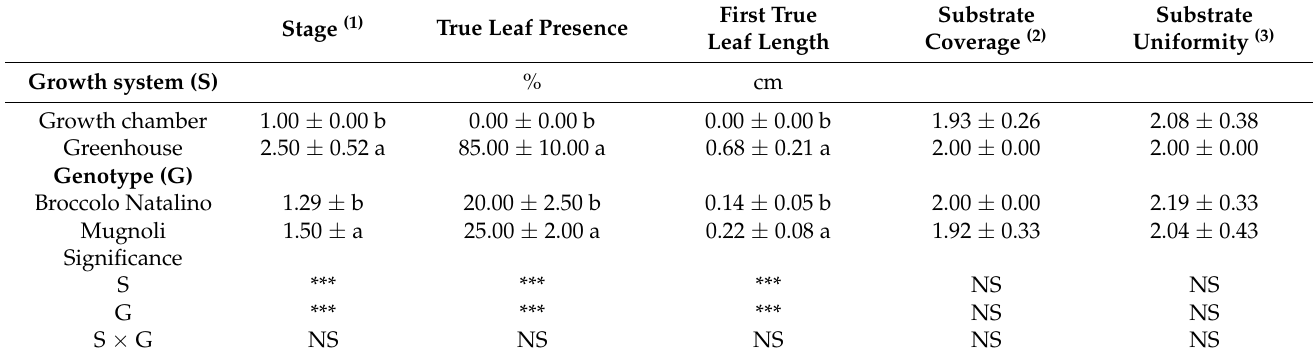
Table 2. Seedling stage, true leaf presence, first true leaf length, substrate coverage, and uniformity at the time of harvest of two brassica microgreens (Broccolo Natalino and Mugnoli) cultivated in a growth chamber and in a greenhouse with sunlight. Means followed by different letters within a column indicate significant differences according to Student–Newman–Keuls (SNK) test at p = 0.05.